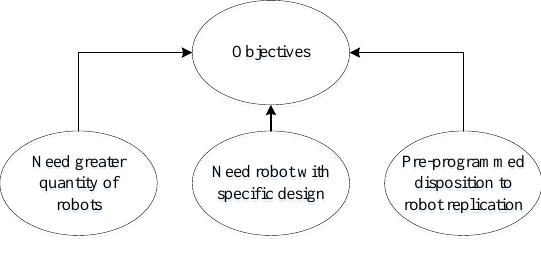
Figure 3. Generic objectives for robot creation.